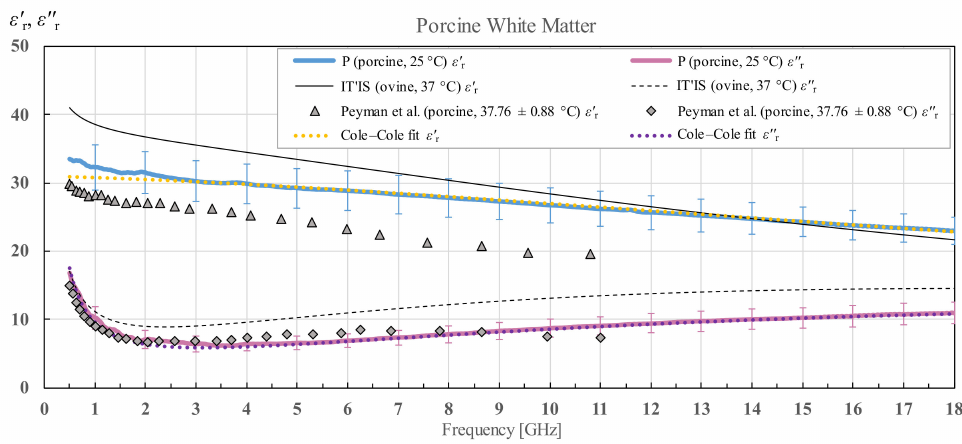
Figure 16. Permittivity of porcine white matter (P) with standard deviation and Cole–Cole fit, shown in comparison with the data from IT’IS database [21] and Peyman et al. [30].